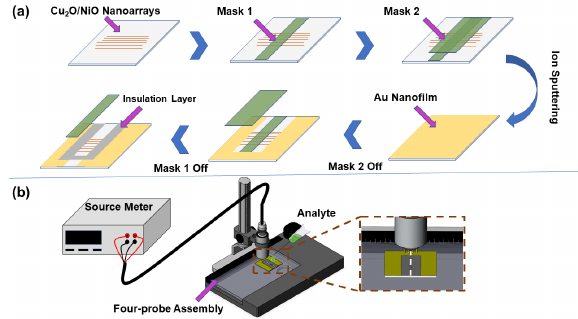
Fig. 1. (a) The schematic fabrication process of Cu 2 O/NiO nanoarrays based sensor. (b) Schematic diagram of connecting samples to the test equipment system.